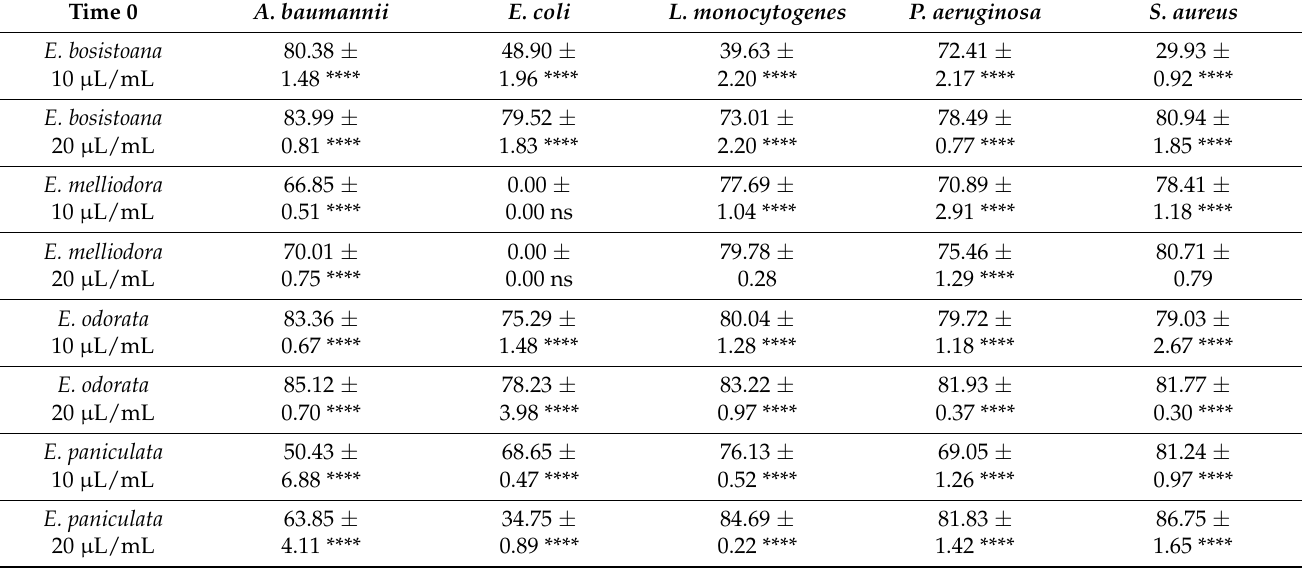
Table 5. Percent of inhibition on sessile cell’s metabolism induced by the presence of the EOs added at the beginning of the bacterial growth (time zero) and after 24